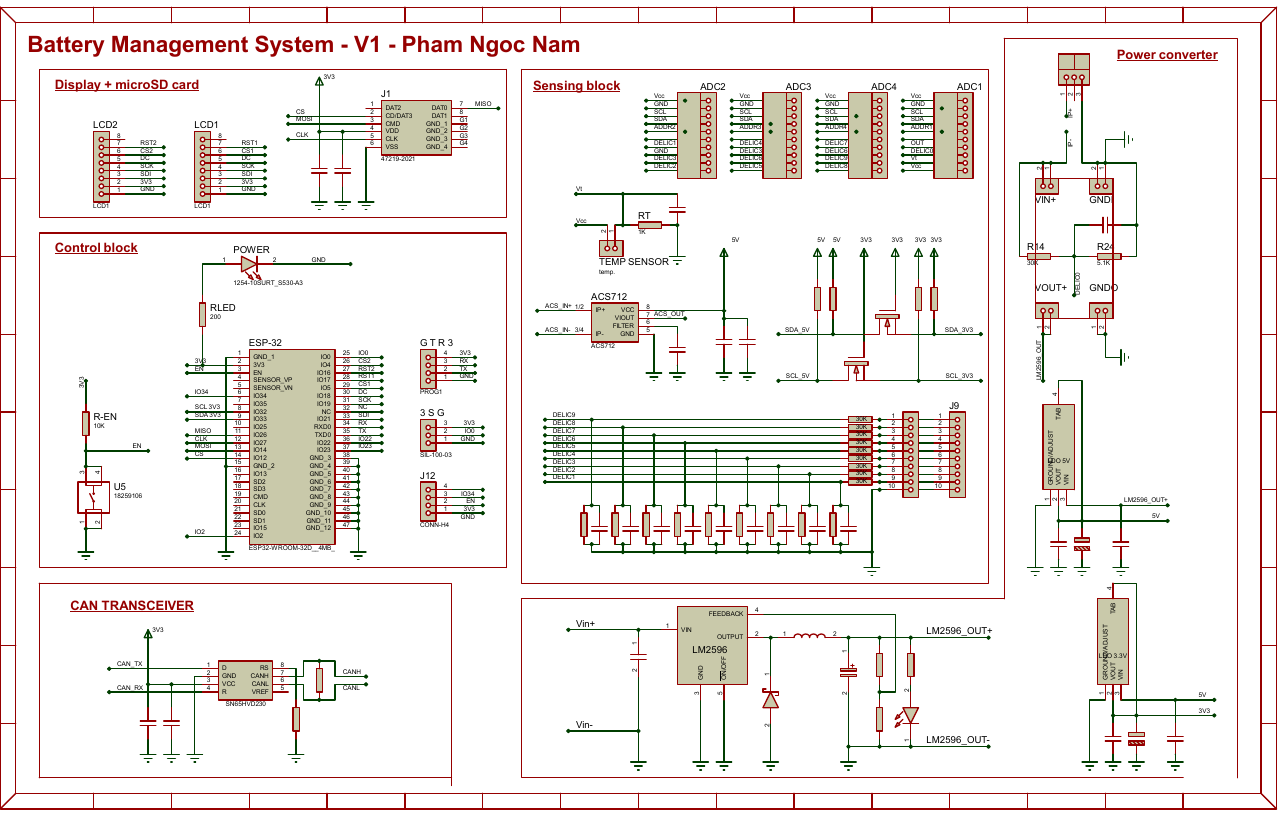
Figure 11. Schematic of BMS system.